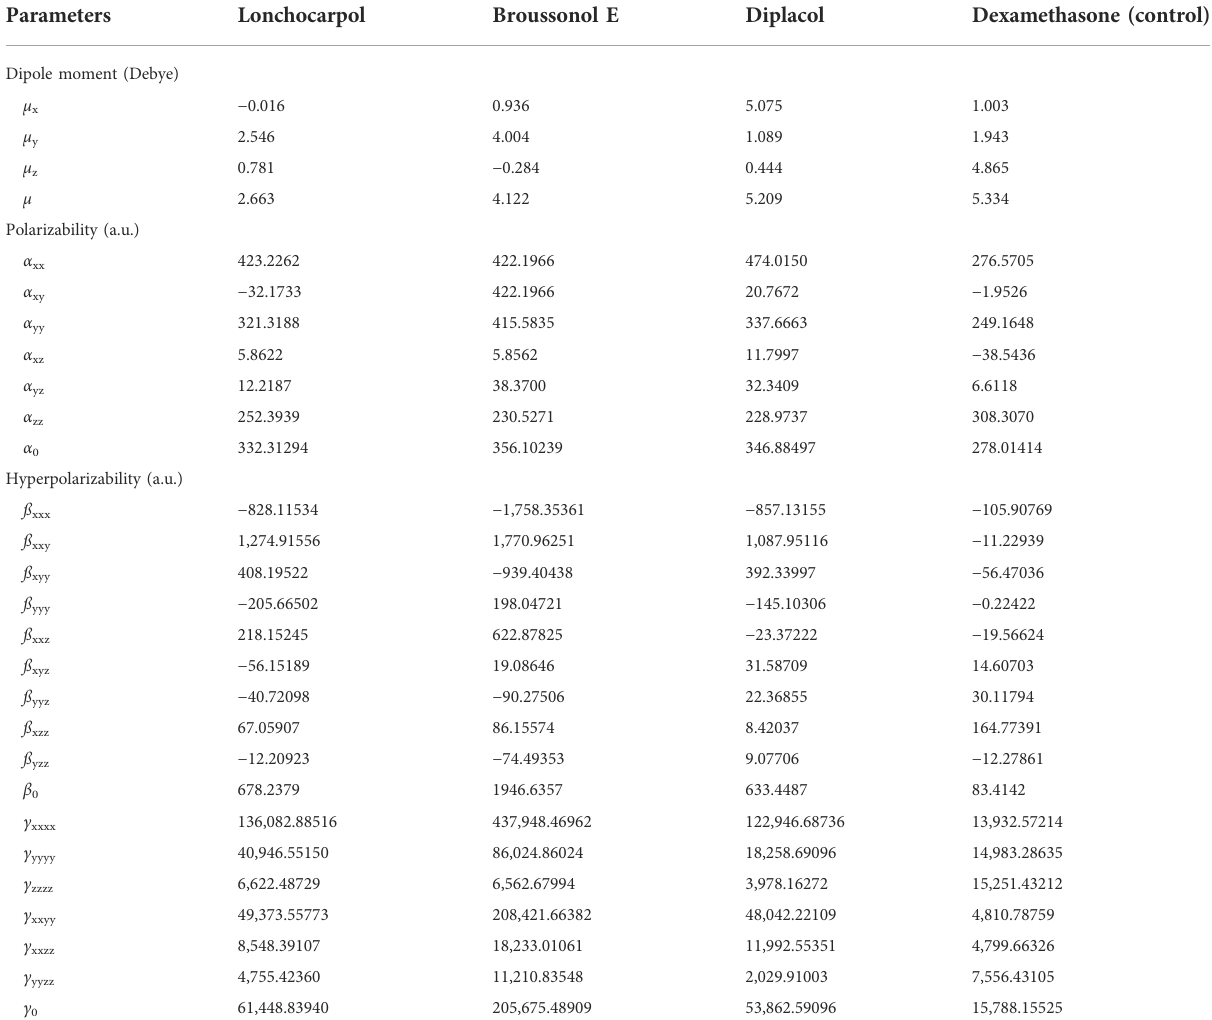
TABLE 3 Non-linear optics (NLO) measurements of the top four compounds.